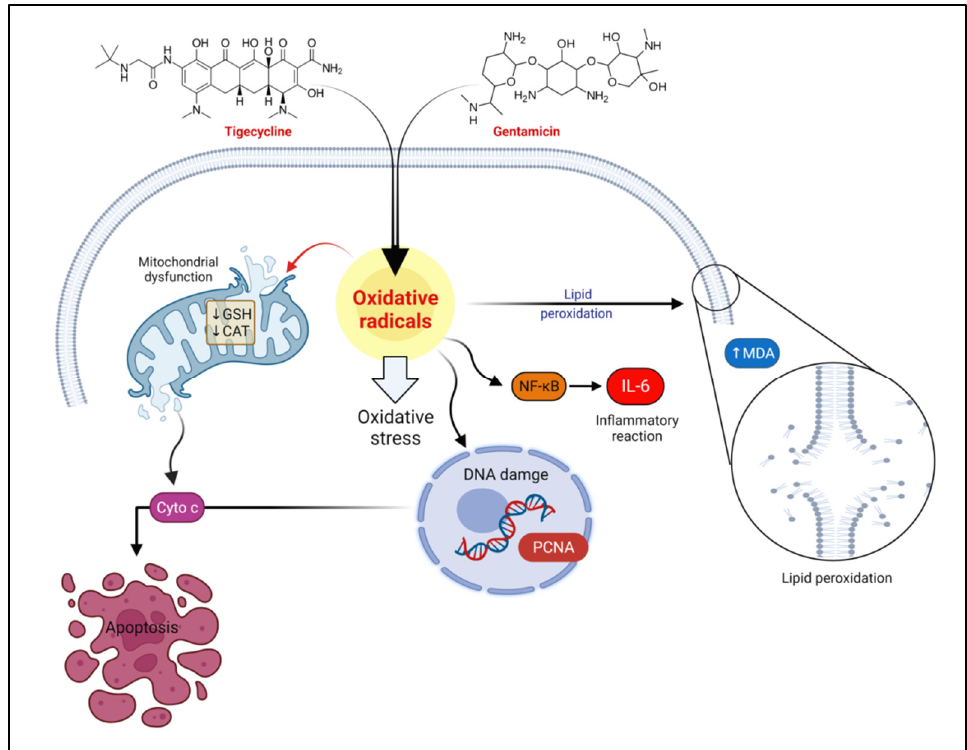
Figure 7. The schematic diagram summarizes the proposed mechanisms behind the tigecycline and gentamicin-potentiated renal injury. CAT, catalase; Cyto c, cytochrome c; GSH, reduced-glutathione; IL-6, interleukin-6; MDA, malondialdehyde; PCNA, proliferating cell nuclear antigen; NF-κB, nuclear factor-kappa B.